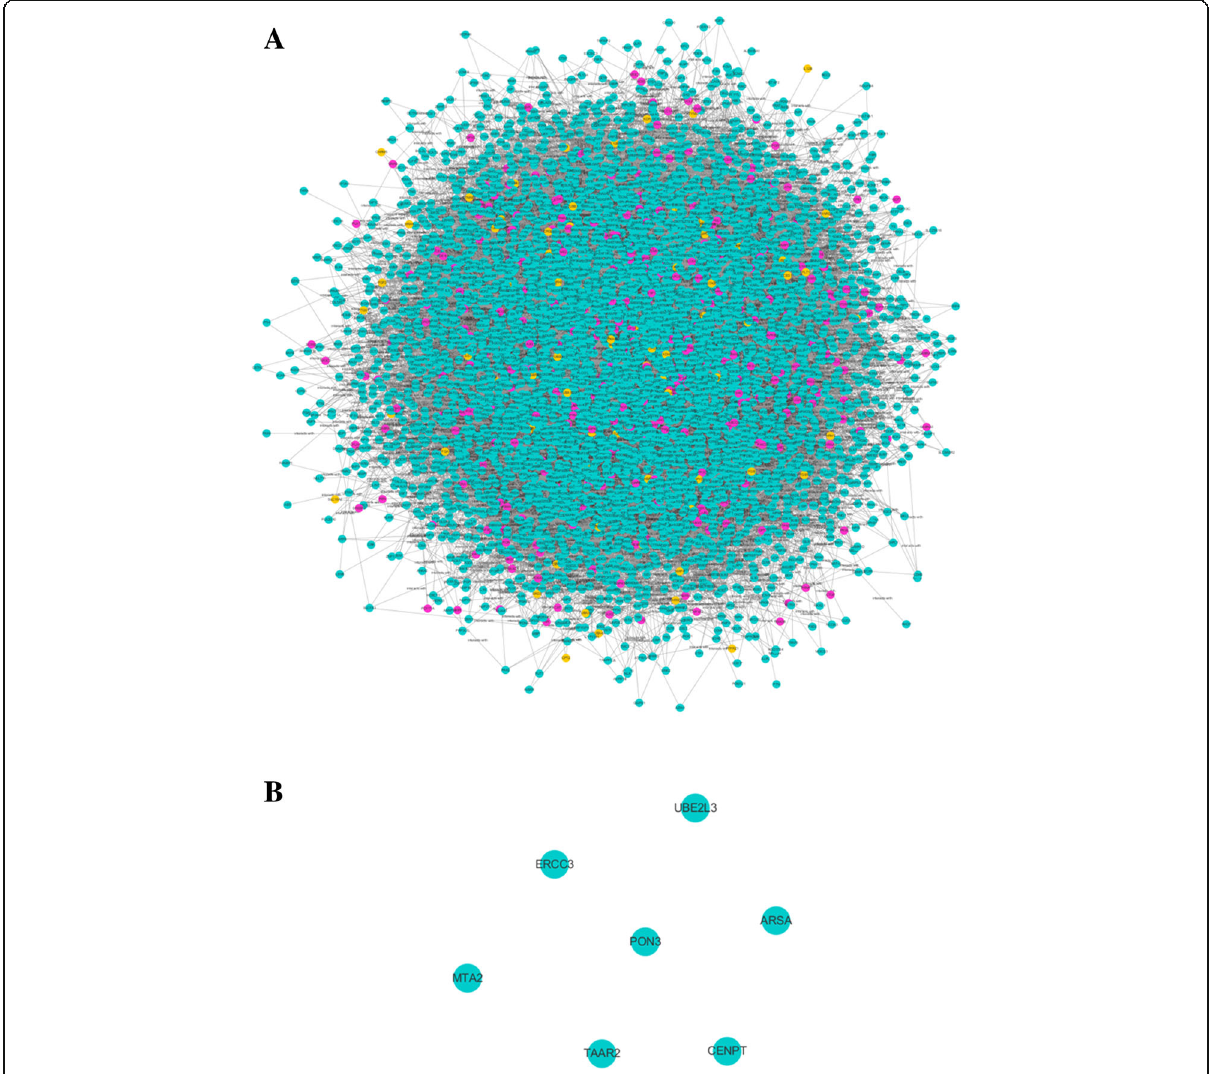
Fig. 4 Null model network. a The null model network composed of the same nodes and the number of edges from ZJW network but randomized links based on Erdös-Renyí model. b The core structure of null model network after calculation of four topological